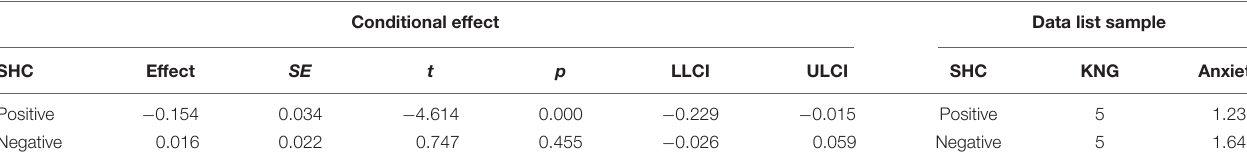
TABLE 4 | Probing the moderating effect of school